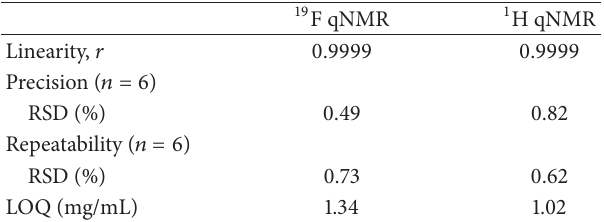
Table 1: Method validation of 19 F and 1 H qNMR